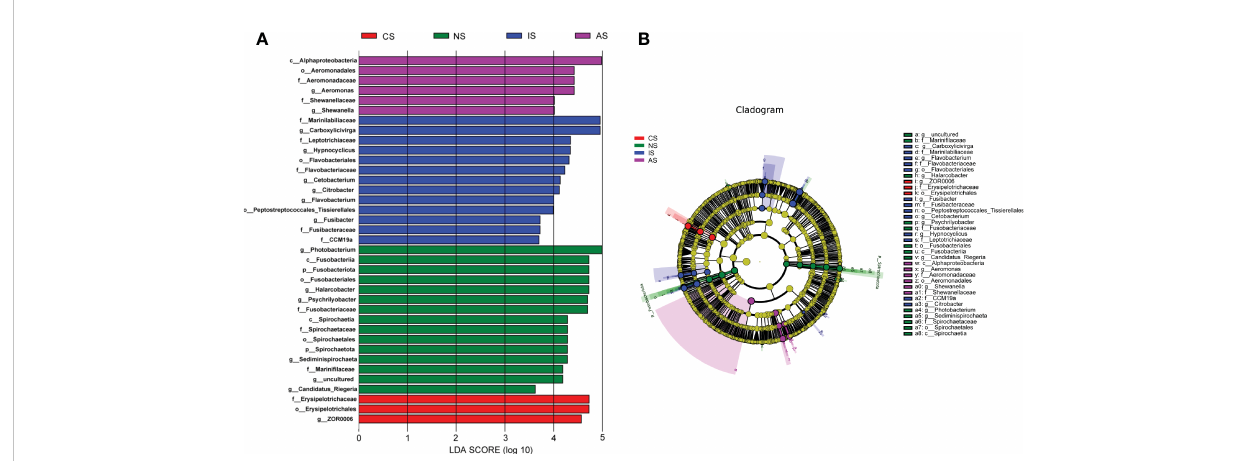
FIGURE 4 Differential bacterial composition of the four groups based on LEfSe Analysis. (A) Histogram of LDA analysis. Different colors represent different groups, different colored bars indicate species with relatively high abundance in different groups; (B) The cladograms of differential bacterial. Different colors represent different groups, color dots corresponding to groups indicate species with relatively high abundance and signi fi cant differences in that group, the yellow dots represent species that were not signi fi cantly different between the four groups, node diameter size is proportional to relative abundance